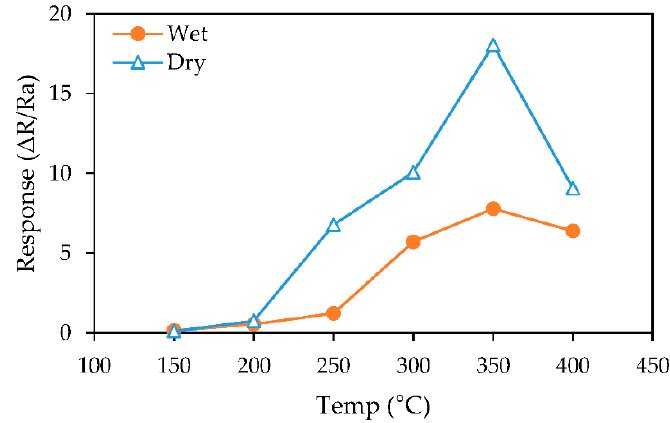
Figure 1. Sensor responses to 20% O 2 as a function of the operating temperature in dry vs. wet air (85%